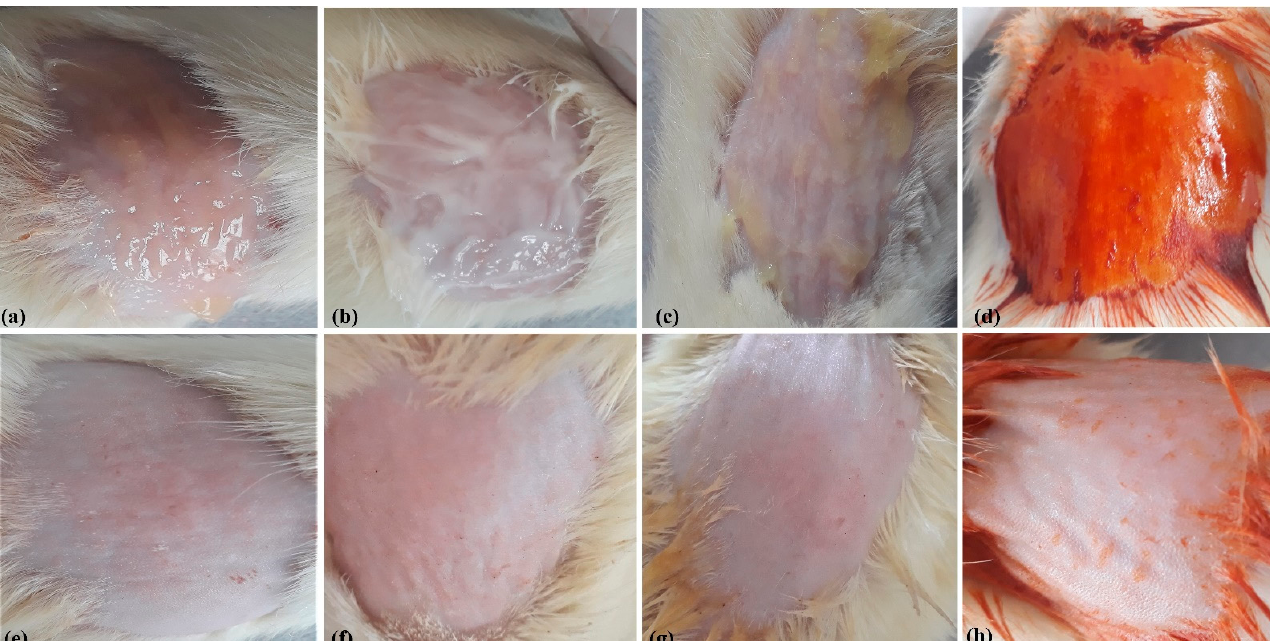
Figure 11 . Skin irritation test; ( a ) optimized formulation subject, Group I; ( b ) marketed formula- tion, Group II; ( c ) controlled subjects (blank transemulgel), Group III; ( d ) standard subject (plain drug), Group IV. After applying the different formulations on skin irritation test animal subjects, their effects are shown in ( e – h ), respectively.